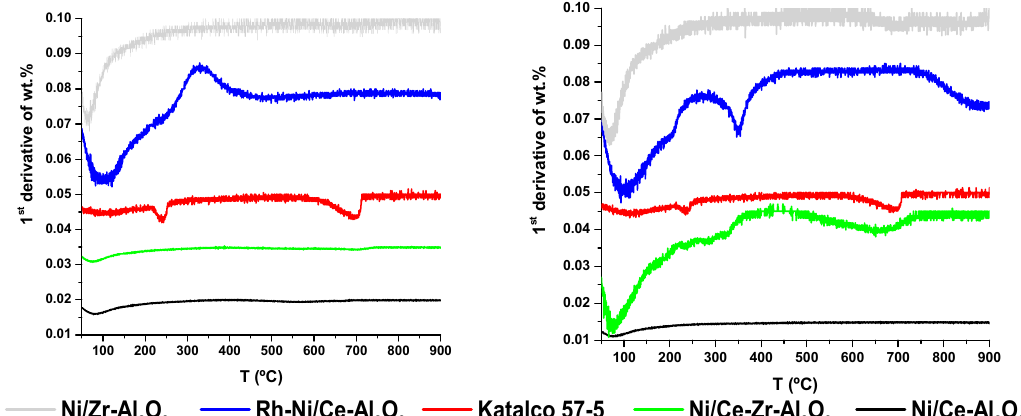
Figure 6. TPO results represented by the first derivative of percentage weight loss for the catalysts tested after self-regeneration ( left ) and regeneration by oxidation ( right ) processes. Reaction conditions: 210.0 mL/min CH 4 , 140.0 mL/min CO 2 , 197.7 mL/min N 2 , 52.5 mL/min O 2 , 0.169 mL/min H 2 O at 800 ◦ C and atmospheric pressure. WHSV of 161.5 g gas · g cat − 1 · h − 1 (0.340 g of each